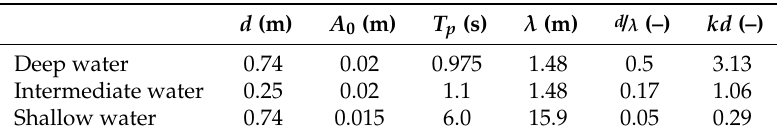
Table 1. Wave characteristics for the wave